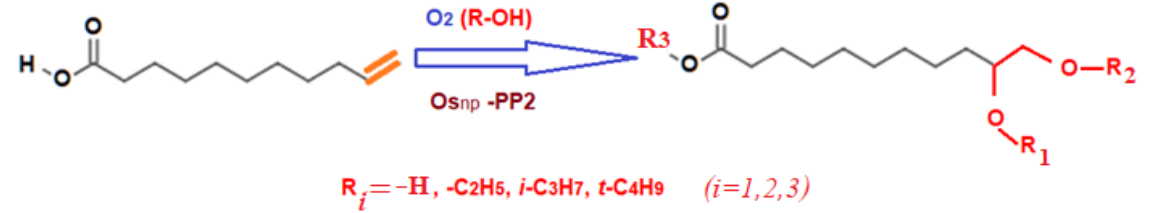
Figure 17. Scheme of molecular oxygen oxidation of 10-undecylenic acid on osmium nanoparticles-polypropylene hollow fibers (Os-PP2) composite membrane.